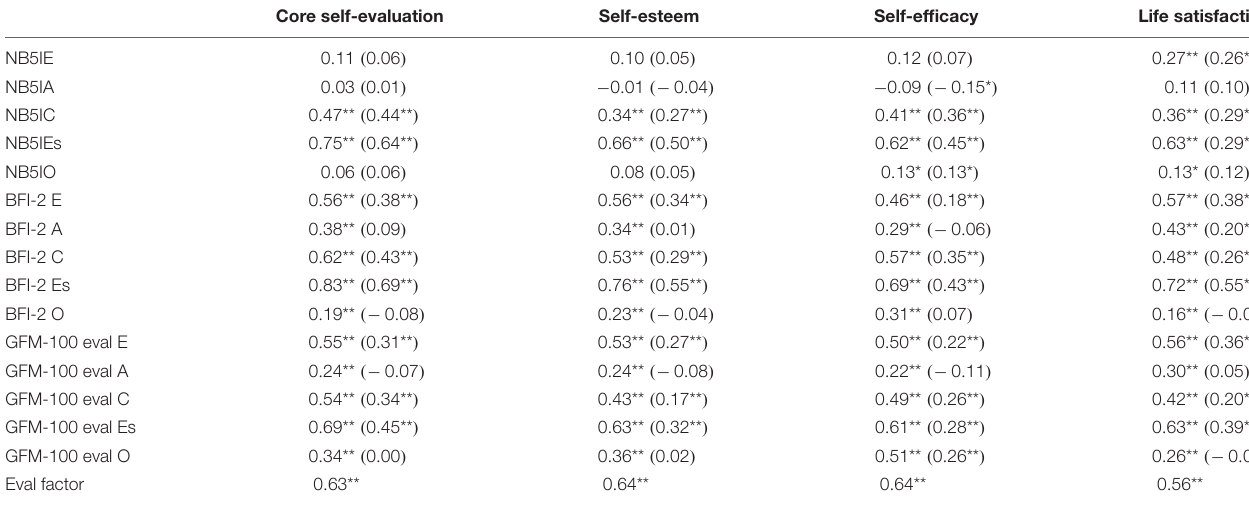
TABLE 6 | Univariate and partial correlations between the factor scales of NB5I, BFI-2, and GFM-100 Eval with Core Self-Evaluations, Self-esteem, Self-efficacy and Life satisfaction in the English-speaking sample. Core self-evaluation Self-esteem Self-efficacy Life satisfaction